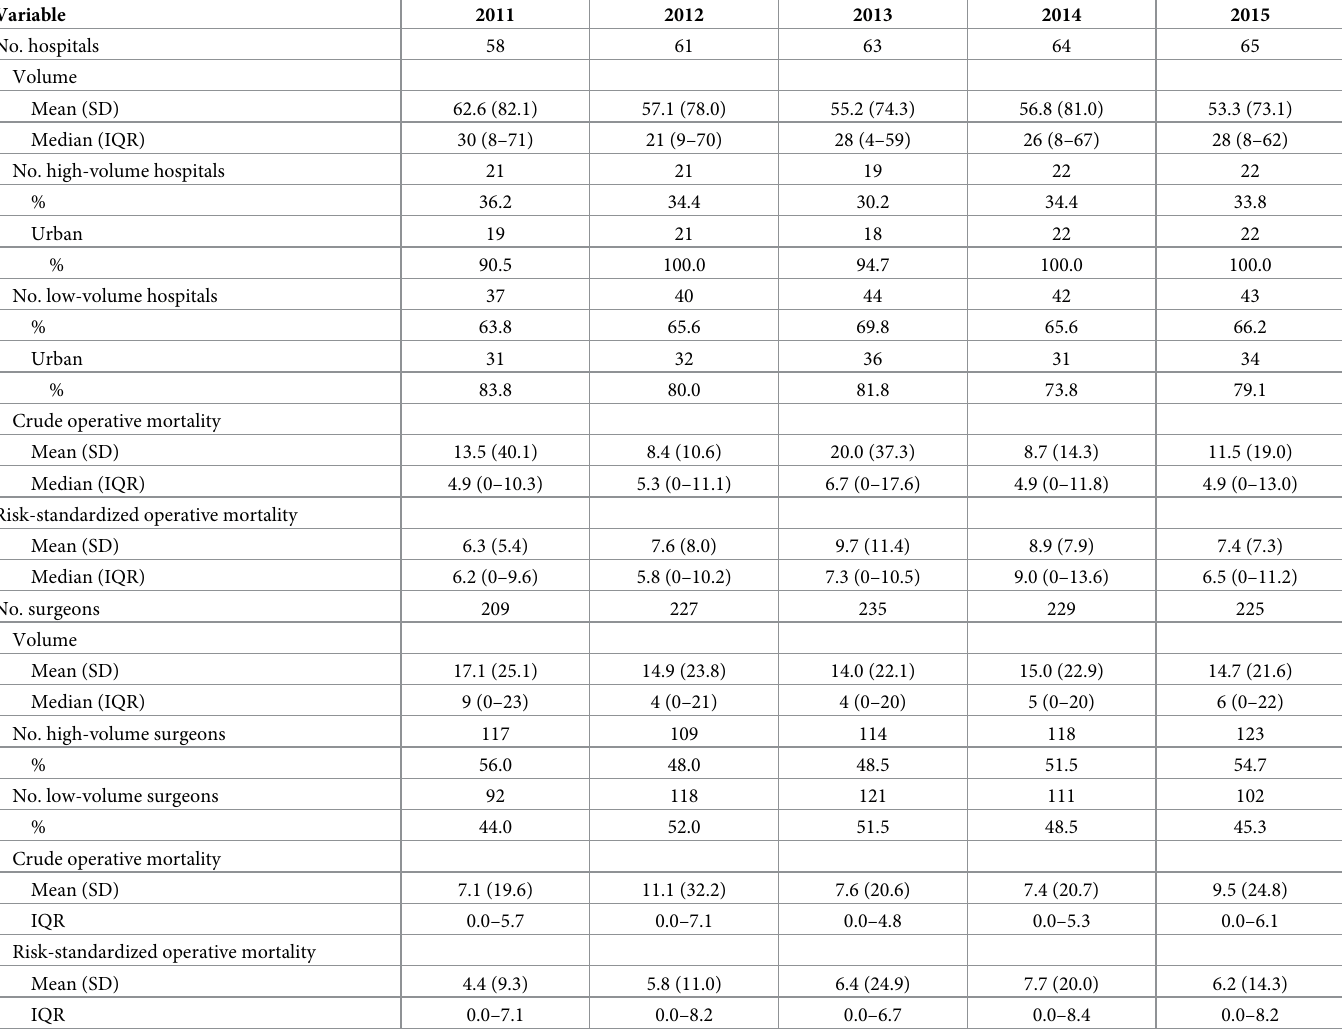
Table 3. Operative mortality and characteristics of hospitals and